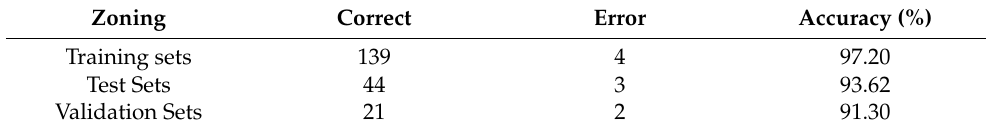
Table 5. Classification results of myocardial ischemia image recognition